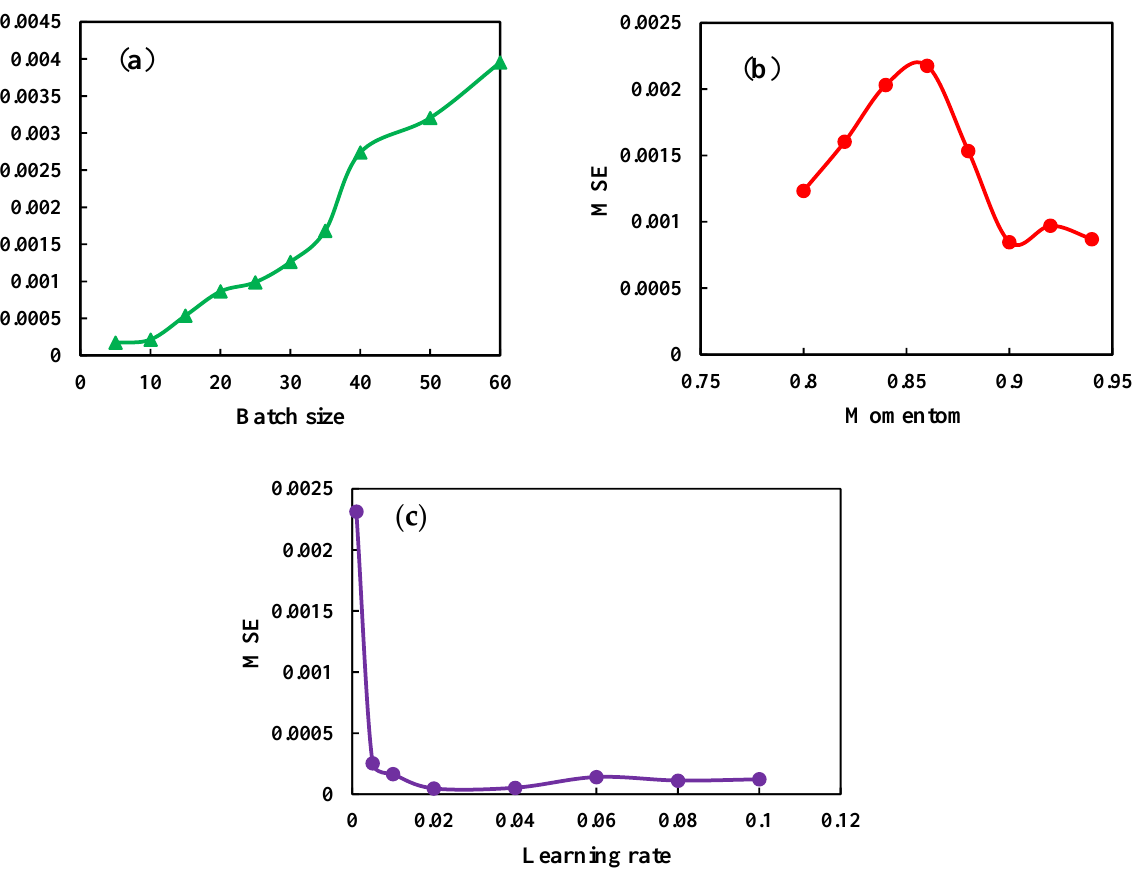
Figure 7. Optimization Parameters SGD algorithm. ( a ) Study the effect of batch size on the MSE. ( b ) Study the effect of momentum on the MSE ( c ) Study the effective learning rate on the MSE. To examine the RBF network and compare it with the MLP network, RBF network parameters should be optimized. Therefore, according to Figure 8, the spread parameter should be optimized by network data.